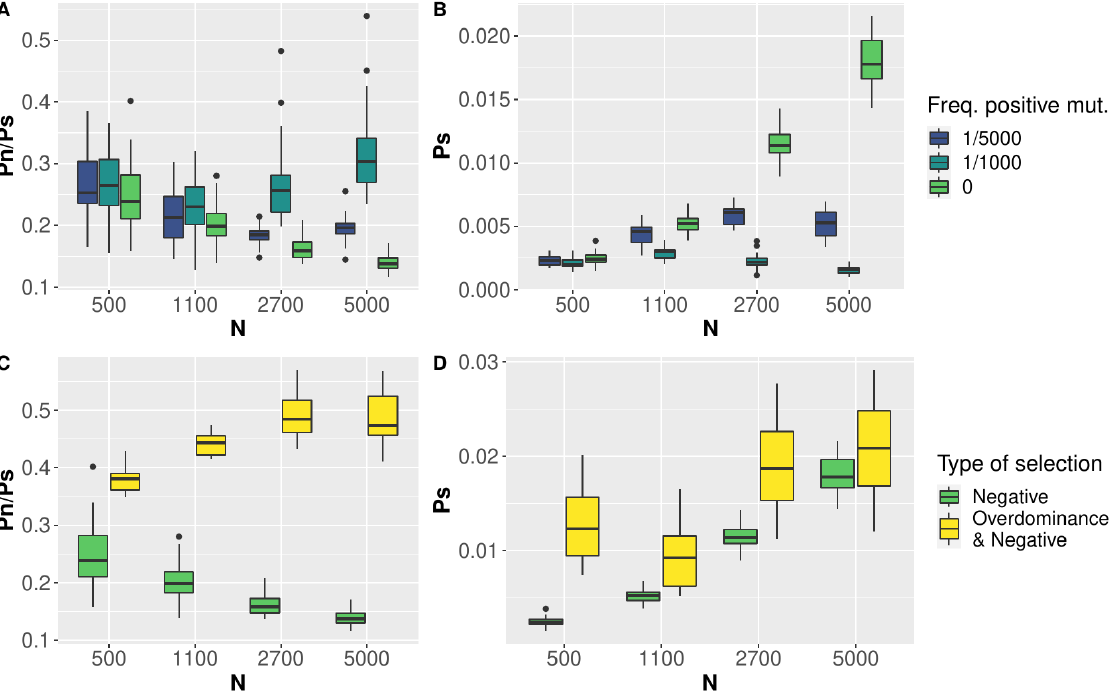
Figure 4: Neutral polymorphism (Ps) and ratio of selected over neutral polymorphism (Pn/Ps) estimated from SLiM simulations. A) Pn/Ps as a function of population size, N and B) Ps as a function of N. In both A and B, color indicates the frequency of positively selected mutations compared to deleterious mutations. C) Pn/Ps as a function of N and D) Ps as a function of N. In both C and D, yellow indicates simulations with overdominance mutation (h = 1.2) and negatively selected mutations and green indicates simulations with only negatively selected